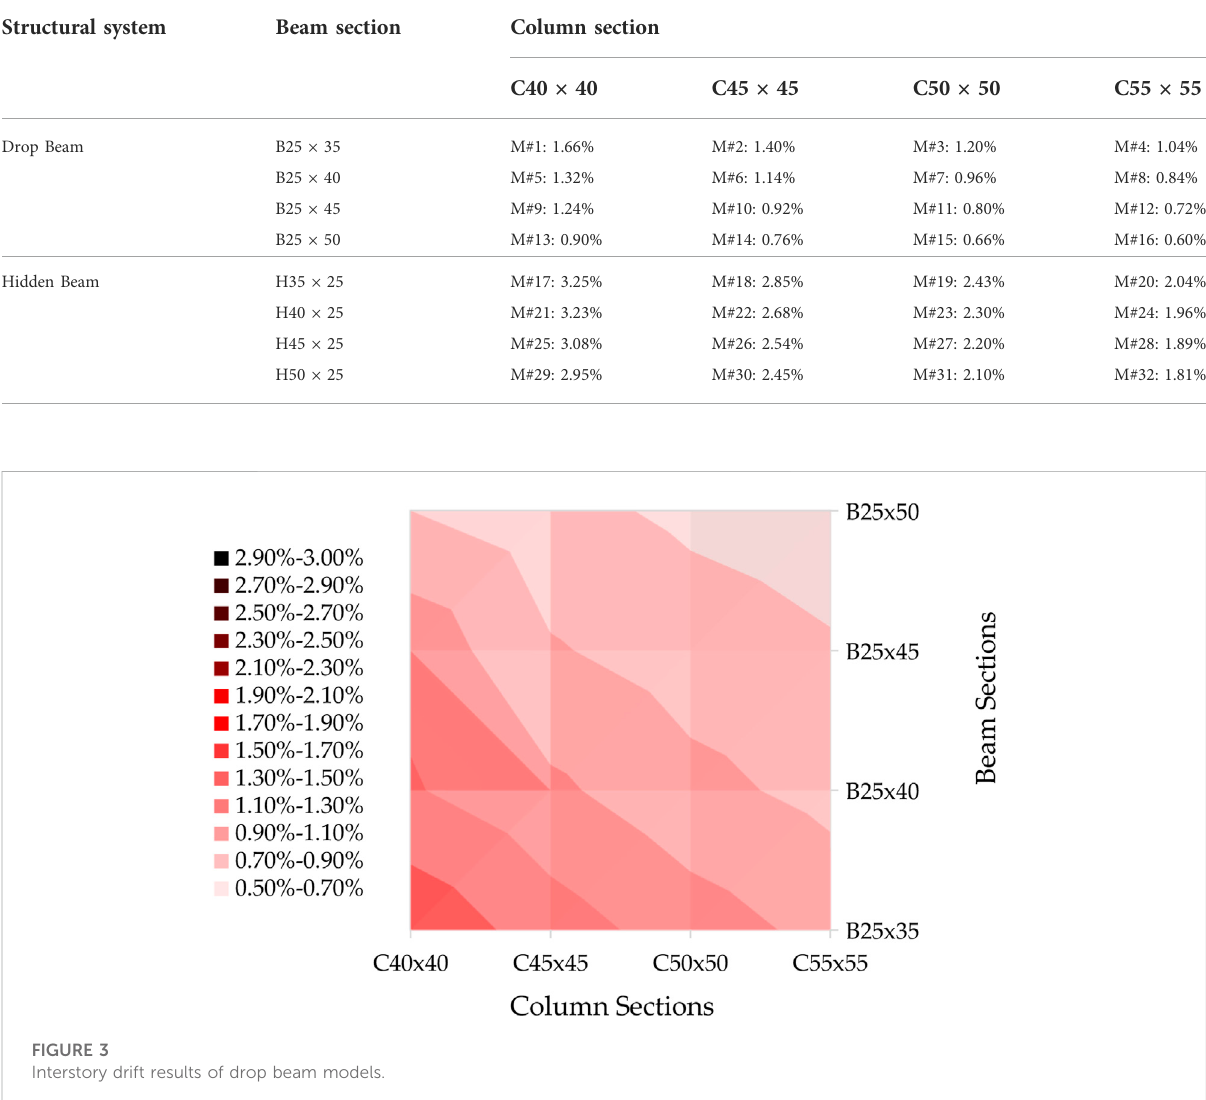
TABLE 6 Interstory drift results.